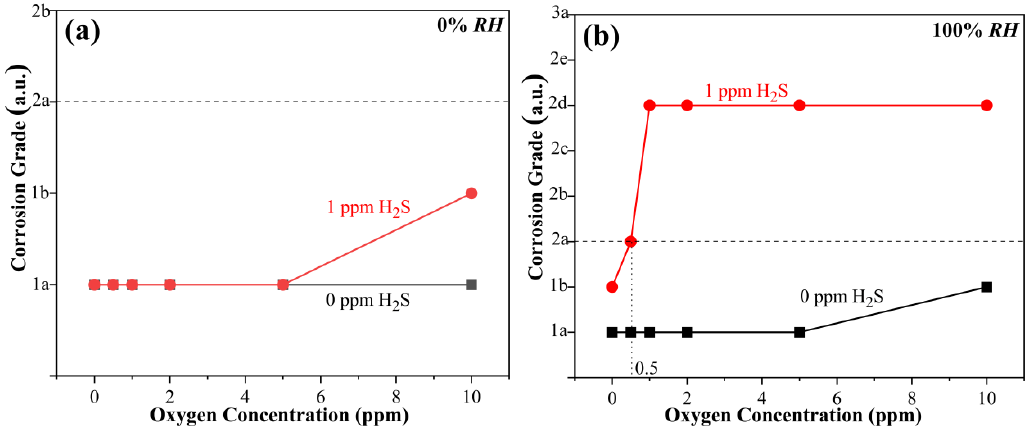
Figure 3. Influence of oxygen concentration on copper corrosion grade in H 2 S-containing LPG at ( a ) 0% RH , ( b ) 100% RH .